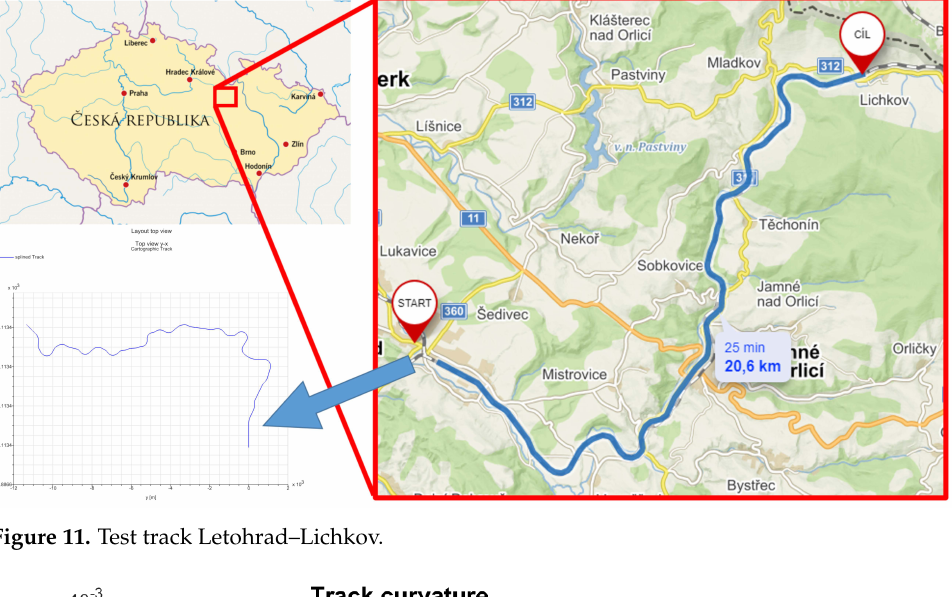
Figure 11. Test track Letohrad–Lichkov.